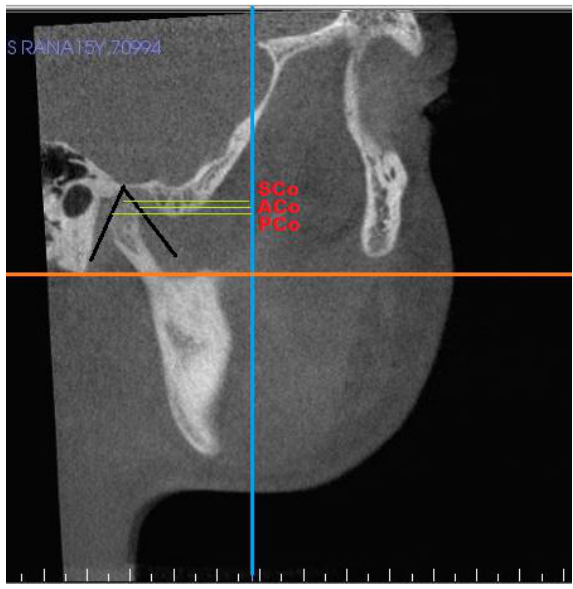
Figure 5. Condyle position measurements: SCo – T vertical; ACo – PT vertical; PCo – PT vertical.